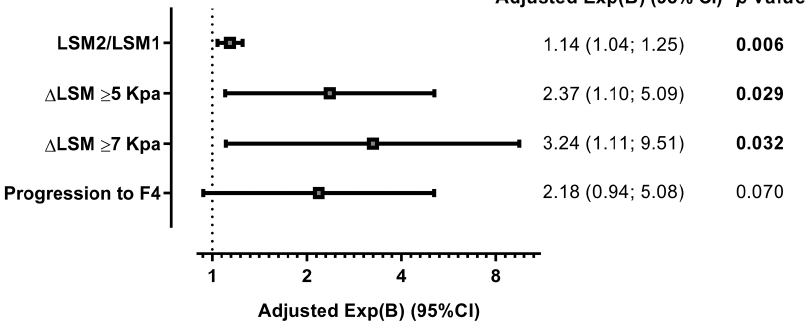
Figure 2. Summary of the adjusted association between the MERTK rs4374383 SNP and the change in LSM values and fibrosis stage in patients infected with HCV under an additive inheritance model. Statistics: p -values were calculated using multivariate regression models adjusted by the clinical and epidemiological characteristics (see statistical analysis section). The statistically significant differences are shown in bold. Abbreviations: MERTK, myeloid-epithelial-reproductive tyrosine kinase; p -value, level of significance; LSM, liver stiffness measure; Δ or delta, change in one variable ( Δ x (x2 − x1)); LSM1, baseline LSM; LSM2, final LSM; F4, cirrhosis; kPa, kilopascal; Exp(B), exponentiation of the B coefficient, which was an arithmetic mean ratio (AMR) for continuous variable and an odds ratio (OR) for categorical variables; 95% CI, 95% of confidence interval.